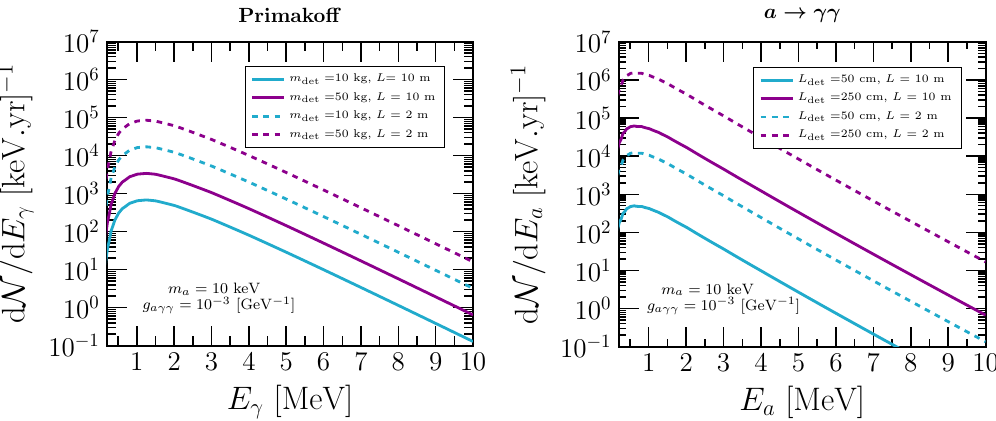
Figure 7 . Left graph : ALP differential event rate for the case of production and detection through Primakoff scattering (applicable to ALP models with dominant coupling only to photons) for differ- ent values of the reactor-detector baseline and detector masses. Right graph : same as in left graph, but for detection through ALP decay, a → γγ . The reactor-detector baseline as well as the detector length L vary in this det